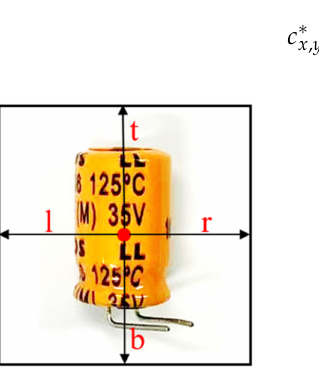
Figure 8. Four bounding box regression